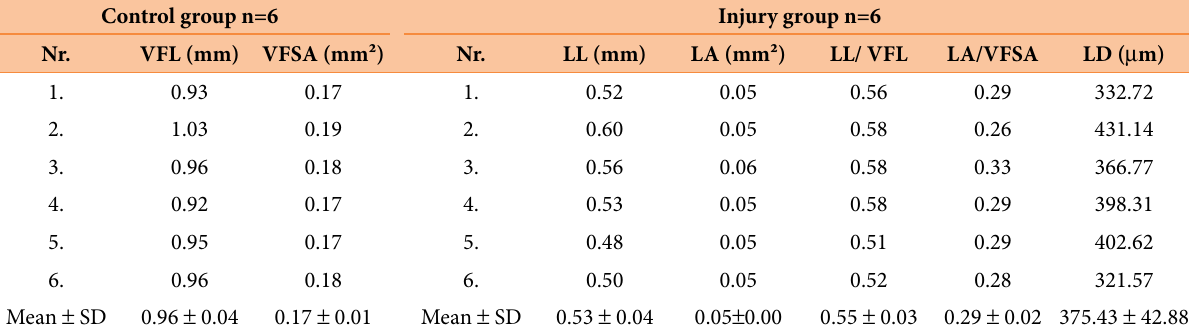
Table 2 - Micro-CT and histological measurements for vocal fold parameters in all